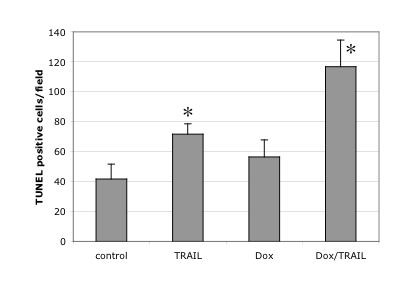
TUNEL staining of PC3 xenografts Mice bearing bilateral PC3 xenografts were untreated or treated with doxorubicin (i.p.) before receiving intratumoral injections of 500 μg Apo2L/TRAIL (left) or vehicle (right). After 24 hours, tumors were harvested, fixed, processed and analysed for TUNEL staining. Data shown are the mean ± SEM calculated from TUNEL positive cells counted in four fields.